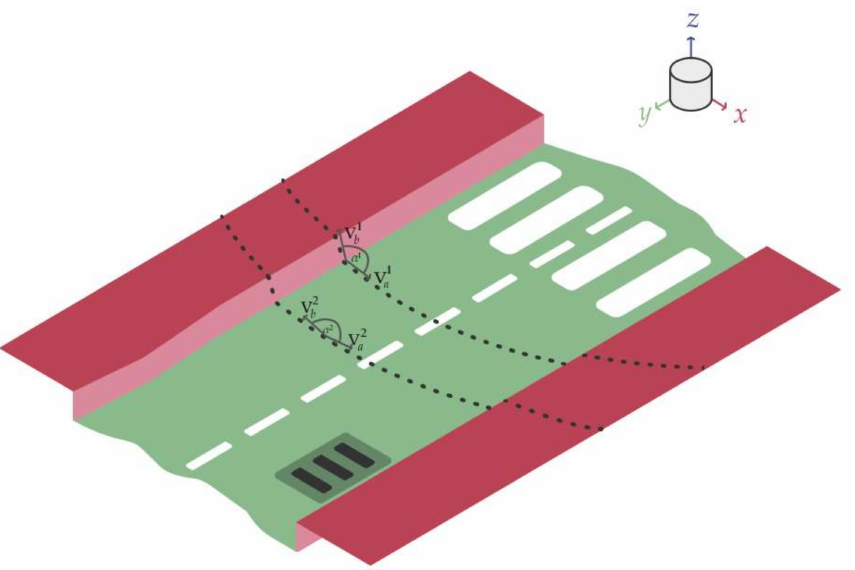
Figure 1. The figure displays the problem. The road is green, and the sidewalk is marked with red. Two channelled measurements are displayed as dotted lines. Moreover, some artifacts such as manholes and other unevenness are